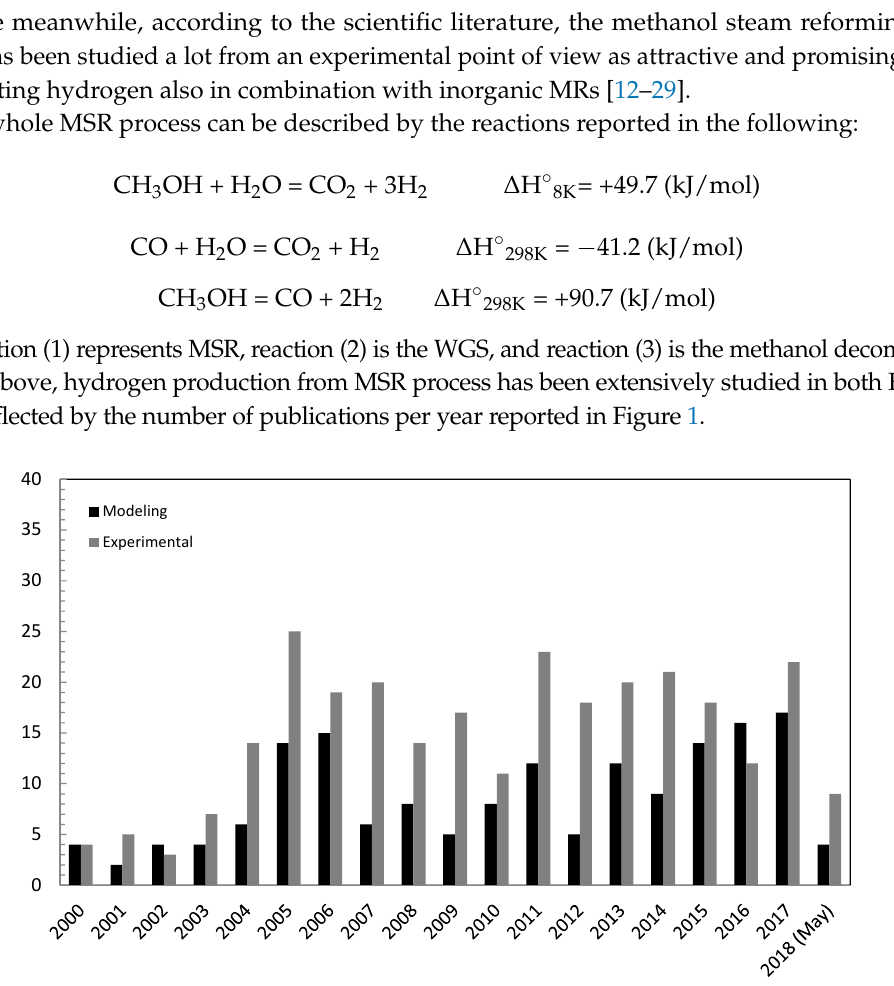
Figure 1. Number of scientific publication (modelling and experimental) versus year about methanol steam reforming (MSR) reaction in both fixed bed reformers (FBRs) and membrane reactors (MRs) (Scopus database: www.scopus.com).